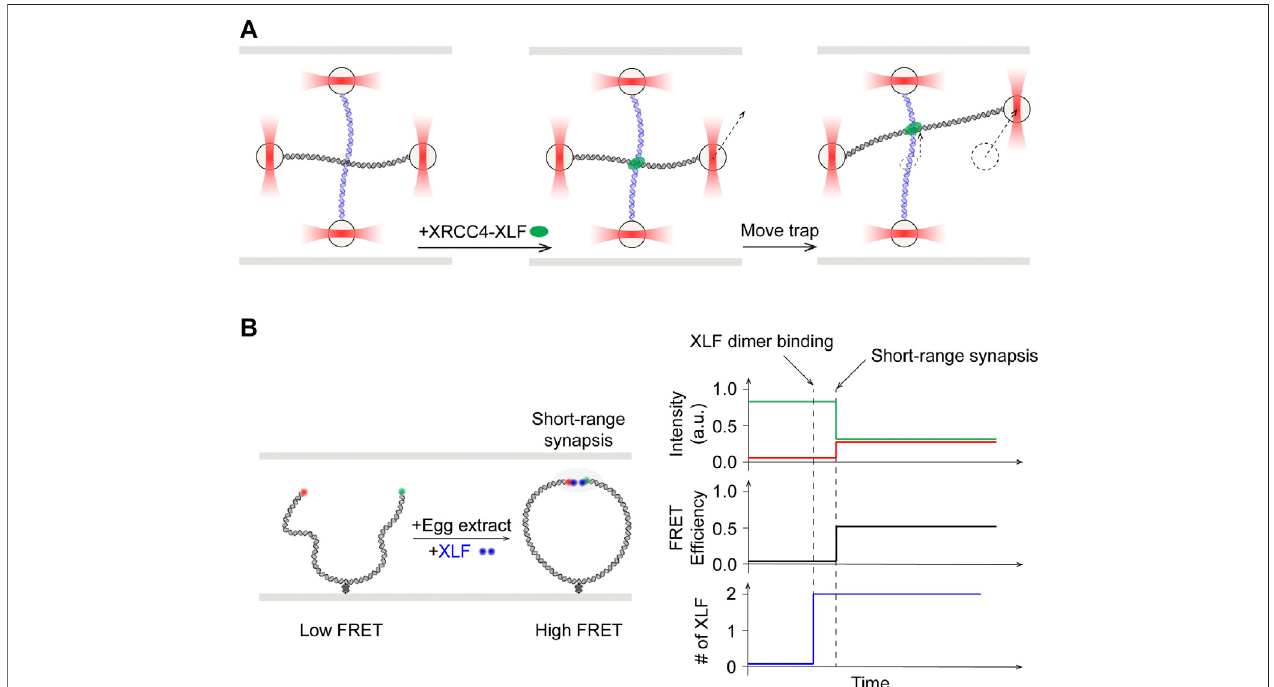
FIGURE 7 | Single-molecule studies of roles of XLF in NHEJ synapsis. (A) Left: Quad optical trap was used to show bridging of two separate DNA molecules by XRCC4-XLF. Middle: One trap was moved to shift one of the two DNA molecules. Right: XRCC4-XLF was able to slide while maintaining the bridge. (B) Left: Schematics of smFRET study using fl uorescently labeled XLF dimer with egg extract. Right: Onset of high FRET, indicative of short-range synapsis between the DNA ends, was preceded by increase in fl uorescence signal corresponding to binding of one XLF dimer.